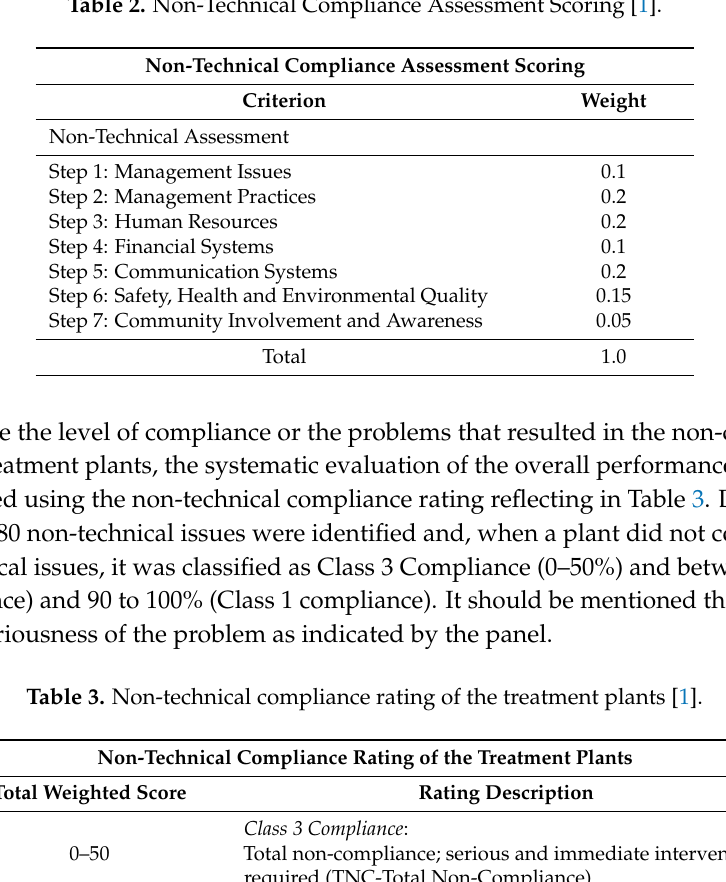
Table 2. Non-Technical Compliance Assessment Scoring [1].